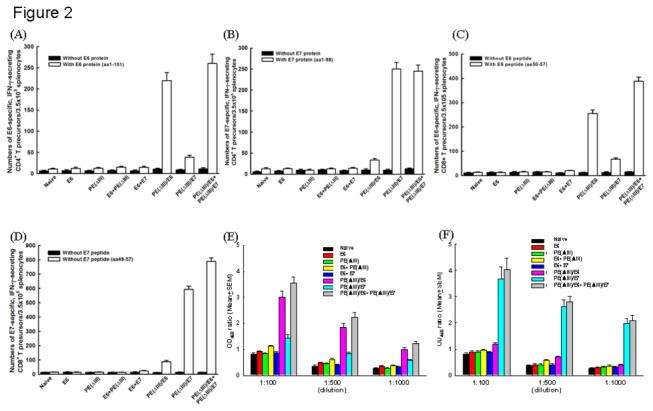
Immunologic profiles of the vaccinated mice using intracellular cytokine staining and ELISA.(A) The number of IFN-γ-secreting CD4+ T cells with (open columns) or without (filled columns) the corresponding E6 protein (aa1-151). Note: The numbers of E6-specific, IFN-γ-secreting CD4+ T cells in the PE(ΔIII)/E6 (219.5±18.9) and PE(ΔIII)/E6+PE(ΔIII)/E7 (260.0±22.4) groups were significantly higher than those in the other groups (p<0.01, one-way ANOVA). (B) The number of IFN-γ-secreting CD4+ T cells in with (open columns) or without (filled columns) the corresponding E7 protein (aa1-98). Note: The numbers of E7-specific, IFN-γ-secreting CD4+ T cells in the PE(ΔIII)/E7 (258.0±18.2) and PE(ΔIII)/E6+PE(ΔIII)/E7 (239.5±17.5) groups were significantly higher than those in the other groups (p<0.01, one-way ANOVA). (C) The number of IFN-γ-secreting CD8+ T cell precursors with (open columns) or without (filled columns) the corresponding E6 peptide (aa 50-57). Note: The PE(ΔIII)/E6 (247.5±18.2) and PE(ΔIII)/E6+PE(ΔIII)/E7 (392.5±19.6) groups generated higher numbers of E6-specific, IFN-γ-secreting CD8+ T precursors than the other groups (p<0.01, one-way ANOVA). (D) The number of IFN-γ-secreting CD8+ T cell precursors with (open columns) or without (filled columns) the corresponding E7 peptide (aa 49-57). Note: The PE(ΔIII)/E7 (588.5±16.8) and PE(ΔIII)/E6+PE(ΔIII)/E7 (778.0±18.9) groups also generated higher numbers of E7-specific, IFN-γ-secreting CD8+ T precursors than the other groups (p<0.01, one-way ANOVA). ELISA demonstrated (E) E6-specific and (F) E7-specific Abs in the mice vaccinated with various protein vaccines. Note: The titers of E6-specific Abs were higher in the PE(ΔIII)/E6 and PE(ΔIII)/E6+PE(ΔIII)/E7 groups than in the other groups (p<0.01, one-way ANOVA). The PE(ΔIII)/E7 and PE(ΔIII)/E6+PE(ΔIII)/E7 also generated significantly higher titers of E7-specific Abs than the other groups (p<0.01, one-way ANOVA).